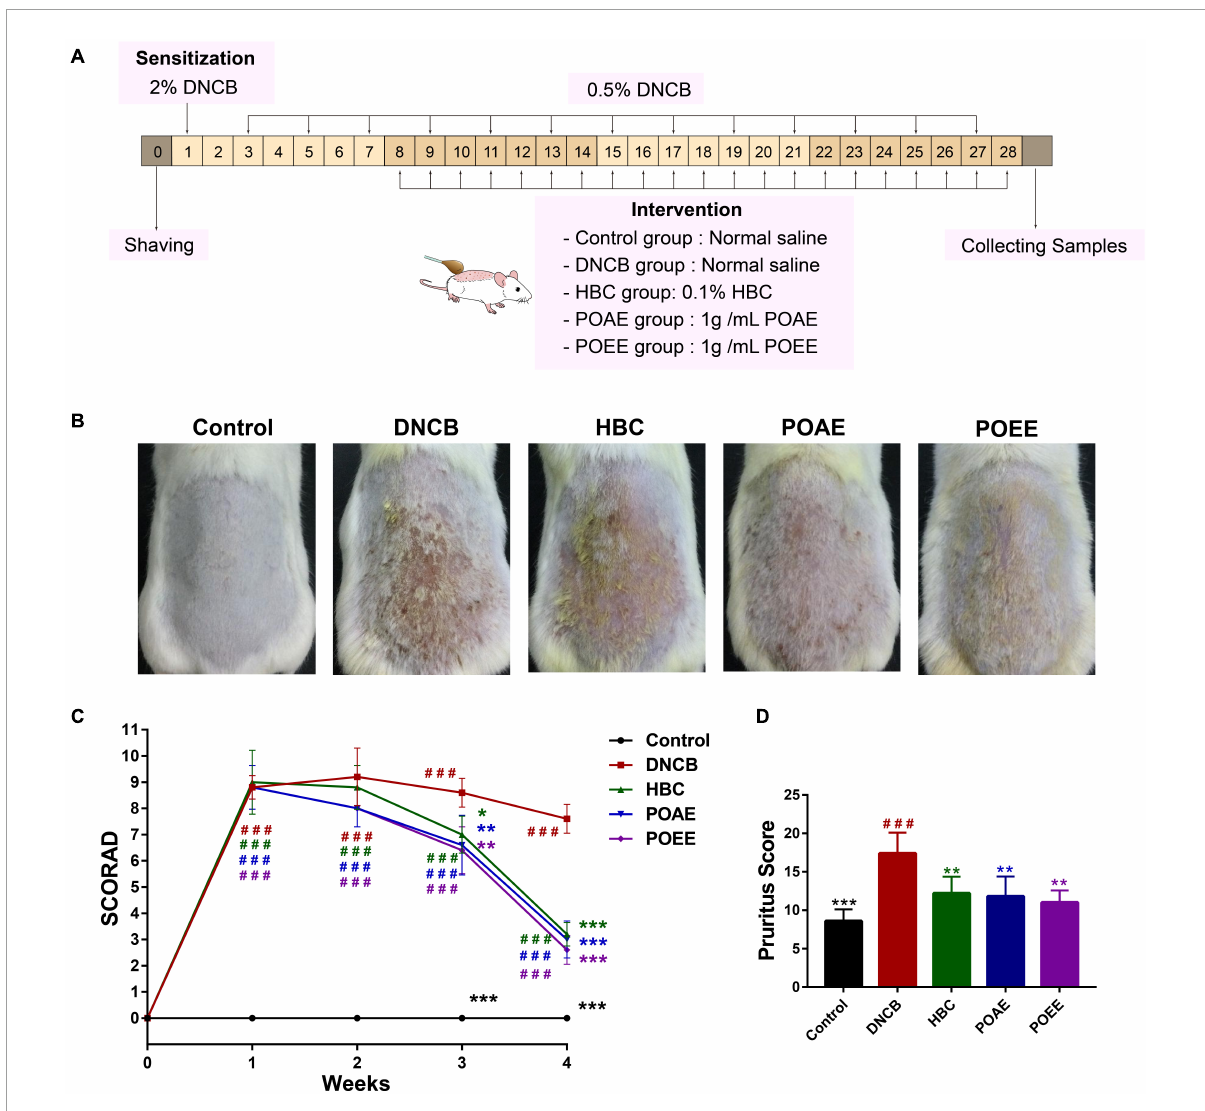
FIGURE2 POAE and POEE significantly alleviate DNCB-induced AD clinical symptoms in mice. (A) Animal experiments. (B) Representative dorsal skin photographs of each group of mice. (C) SCORAD scores of each group of mice. (D) Pruritus scores of mice in each group. The data